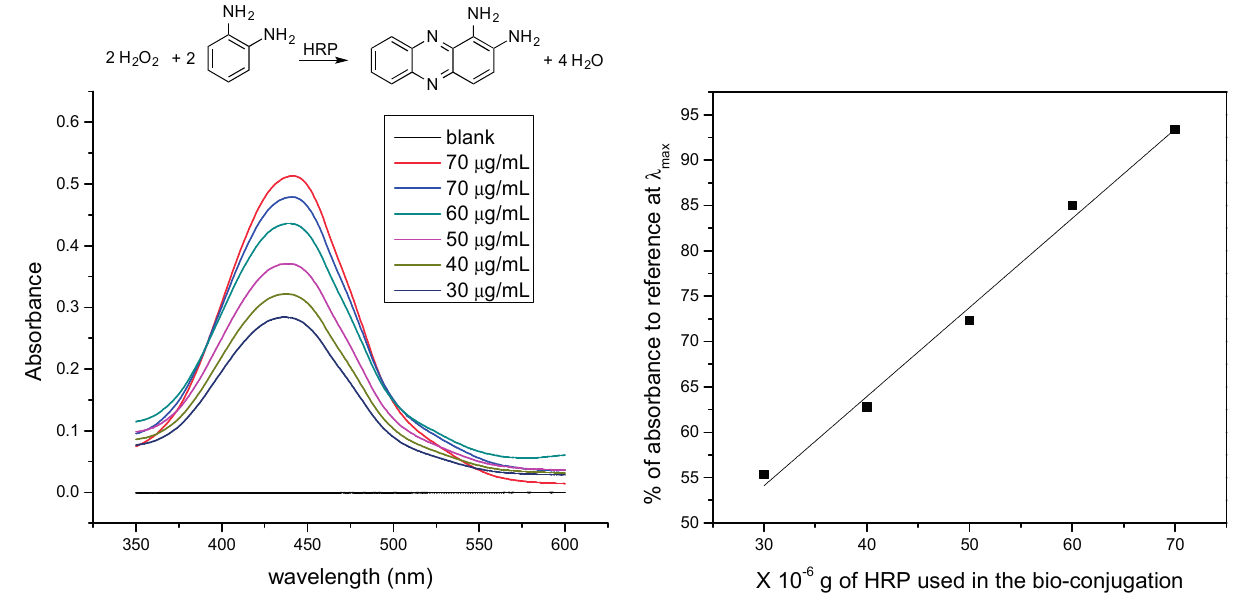
Figure 7. Horseradich peroxidase (HRP) catalysed conversion of o -phenylene diamine dihydrochloride (OPD) into 2,3-diaminophenazine and signficant UV-Vis absorbance peaks of 2,3-diaminophenazine for reactions catalysed by Si-NP conjugated with HRP at a concentration of 1 mg/mL NP in PBS at pH 7.4. Experiments 1–5 represent NP with decreasing amounts of conjugated HRP. The reference sample was recorded with free HRP (70 μ g/mL), while the blank contains no